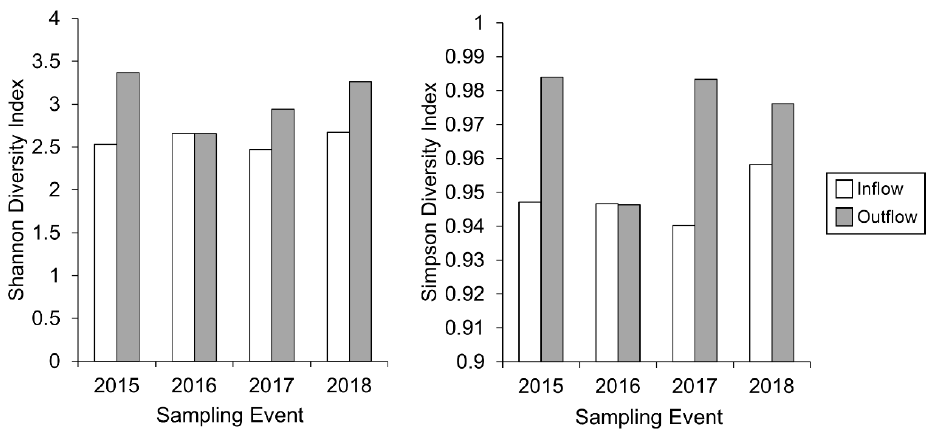
Figure 3. Shannon and Simpson diversity indexes of the periphyton at the inflow and outflow of the Grootspruit wetland over the period of 2015 to 2018.